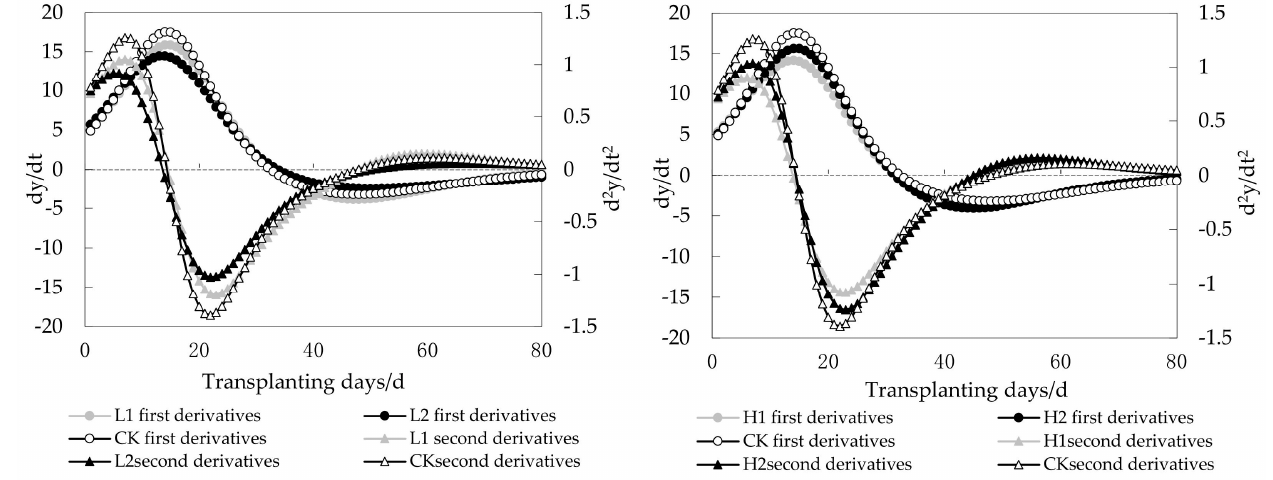
Figure 4. Dynamic analysis of logistic nesting curves for water level management rice stem tiller